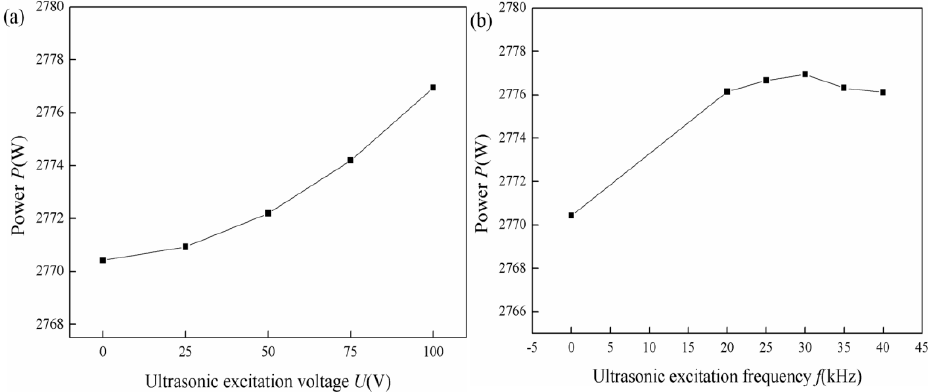
Figure 3. Arc power with different ultrasonic excitation parameters :( a ) ultrasonic excitation voltage; ( b ) ultrasonic excitation frequency. ( b ) ultrasonic excitation